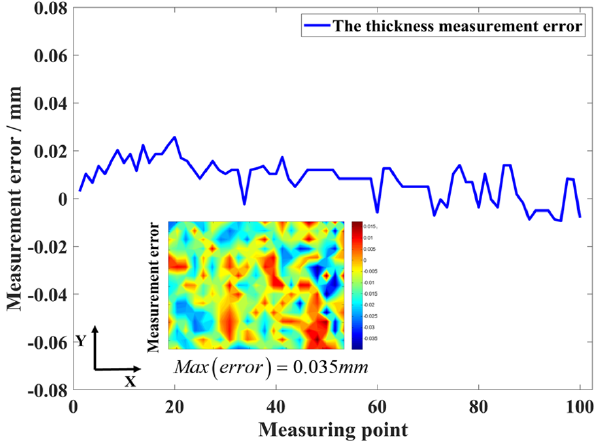
Figure 8. Thickness measurement error